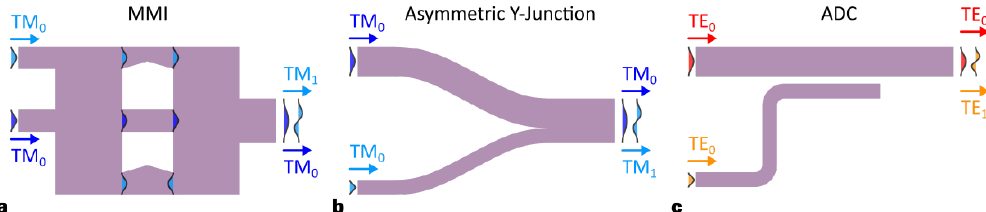
Figure 3. The schematics for the silicon few-mode (de)multiplexers based on ( a ) multimode interference couplers (MMI) [24], ( b ) asymmetric Y-junction [29] and ( c ) asymmetric directional coupler (ADC) [36].